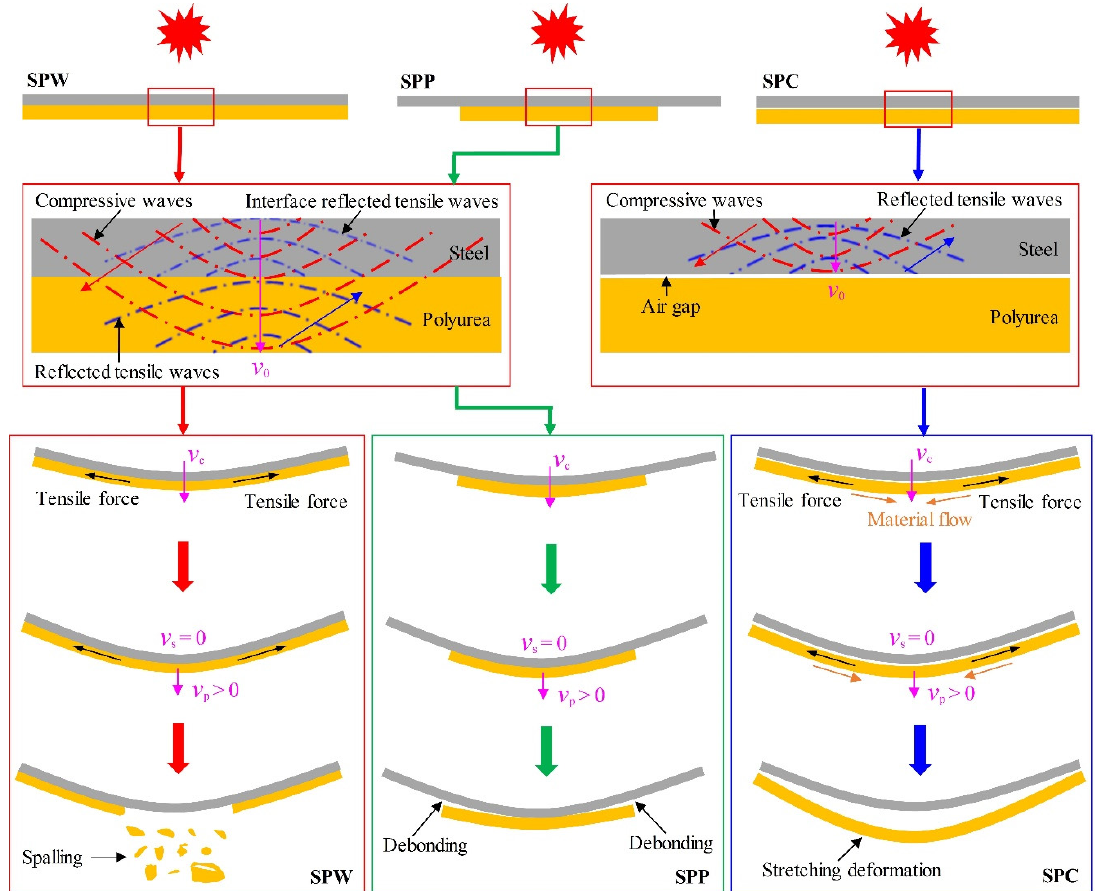
Figure 11. Schematic of stress wave propagation and complex stress states in polyurea backing layers during blast ‐ resistant procedure for SPW, SPP, and SPC plates.